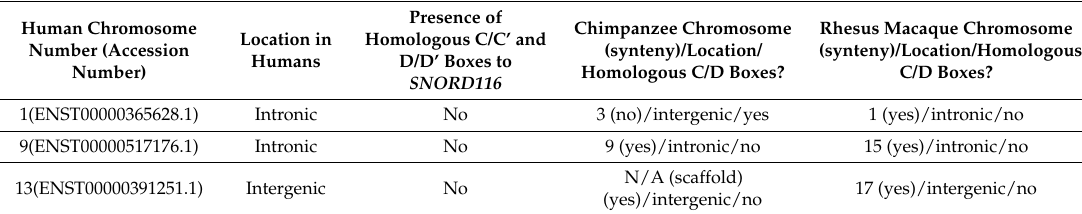
Table 2. Non-cluster paralogs to